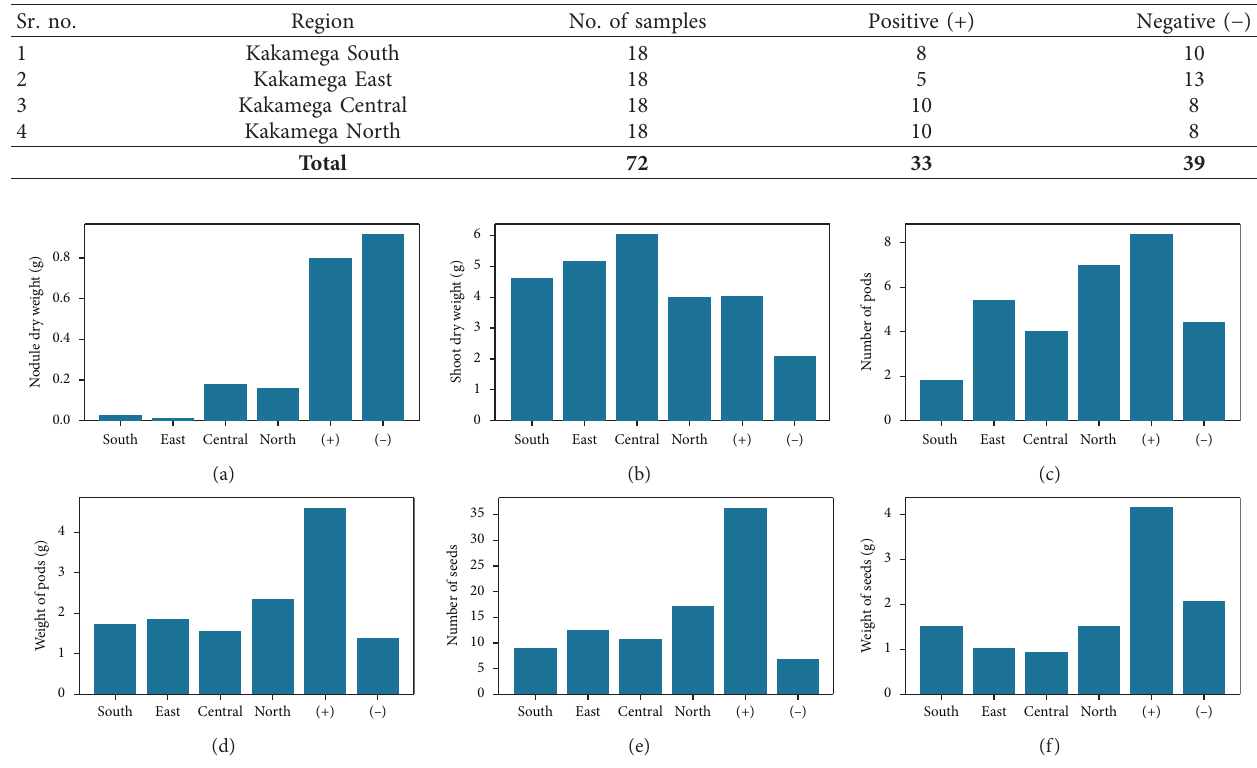
Figure 4: Effects of rhizobia on shoot dry weight, number of pods, pod weight, seed number per plant, and weight of